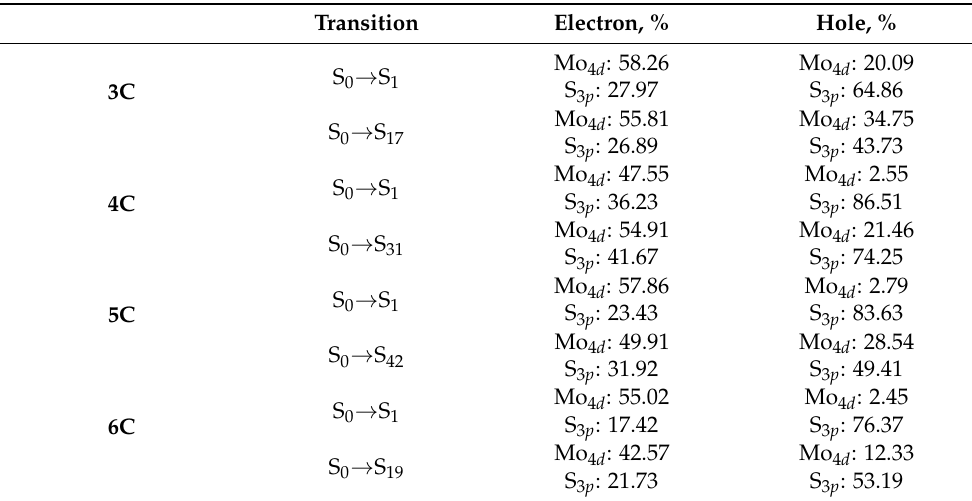
Table 6. S 0 → S 1 transition, S 0 → S n transition, and the percentage of Mo 4 d and S 3 p in electron and hole of 3C , 4C , 5C , and 6C